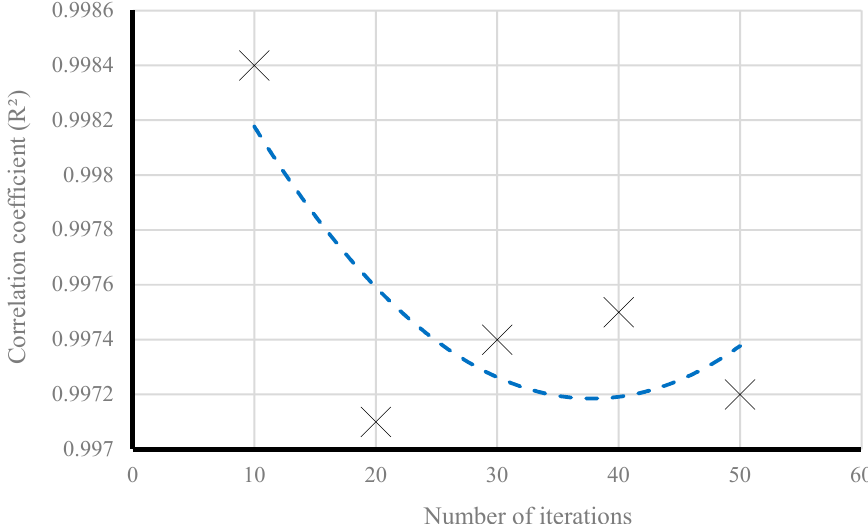
Figure 8. Variation of the correlation coefficient (R²) versus number of iterations, in alternating model tree (AMT) technique.